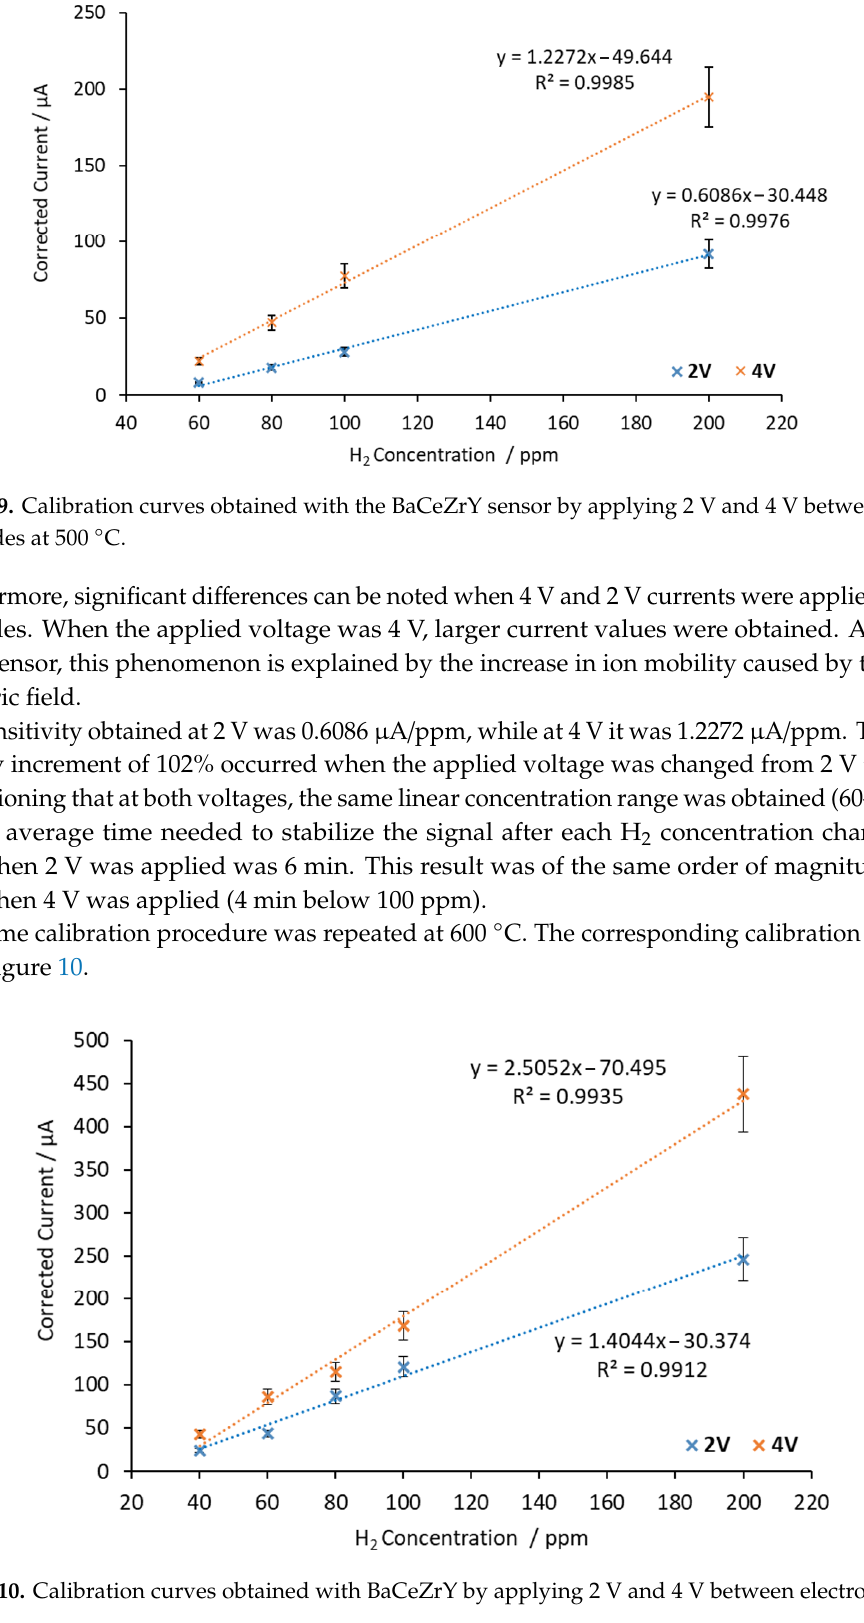
Table 2. Sensitivity results obtained from chronoamperometry tests with the BaCeZrY sensor at 500 °C and 600 °C and at 2 V and 4 V.